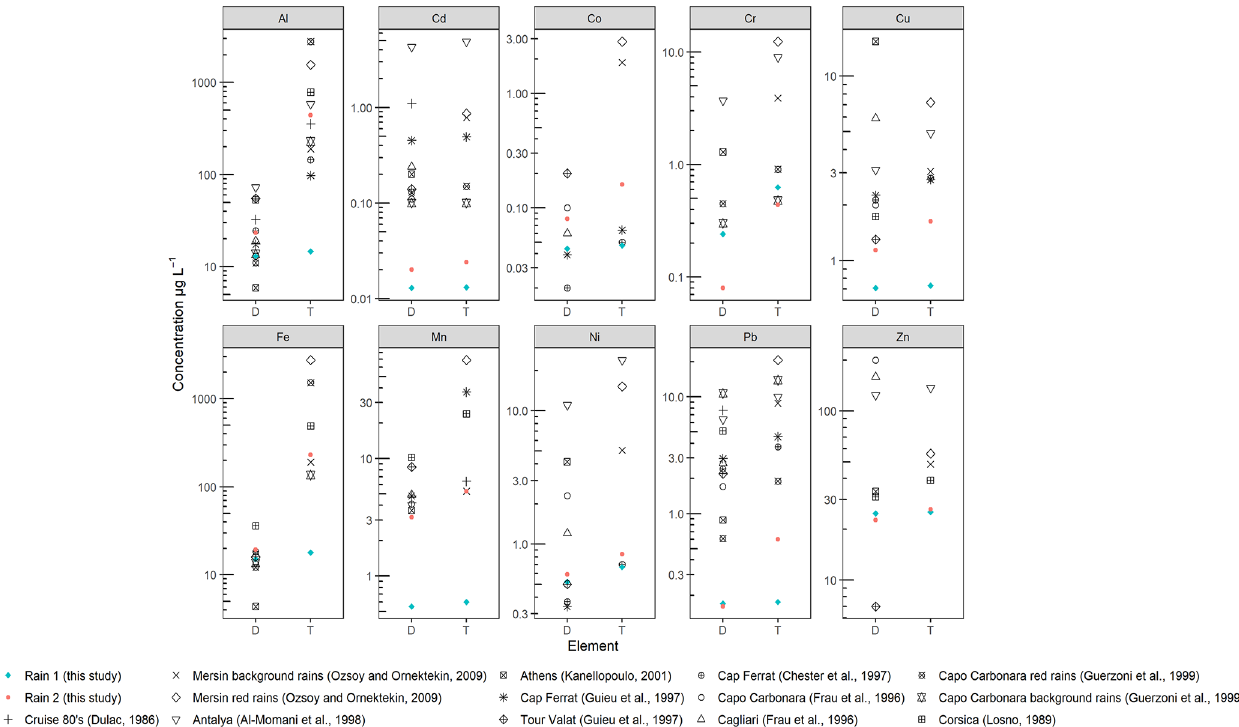
Figure 6. Comparison of dissolved (D) and total (T) TM concentrations to previous studies in the eastern and western Med Sea.